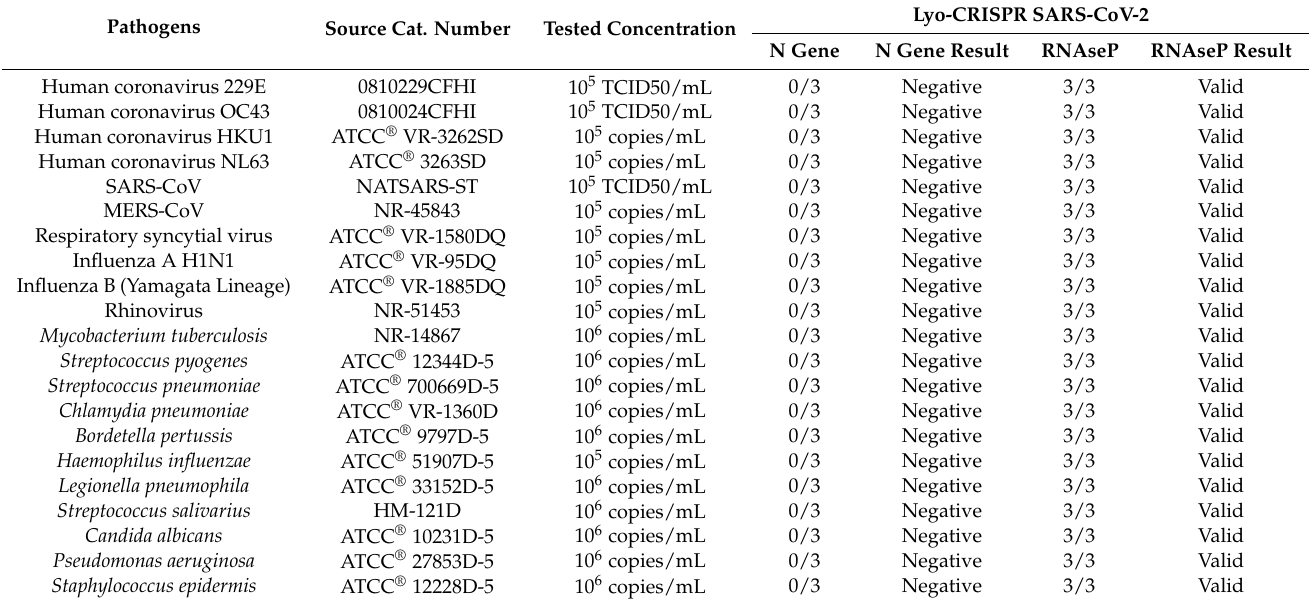
Table 3. Cross-reaction evaluation of Lyo-CRISPR SARS-CoV-2 kit with other respiratory pathogens. Pathogens Source Cat.